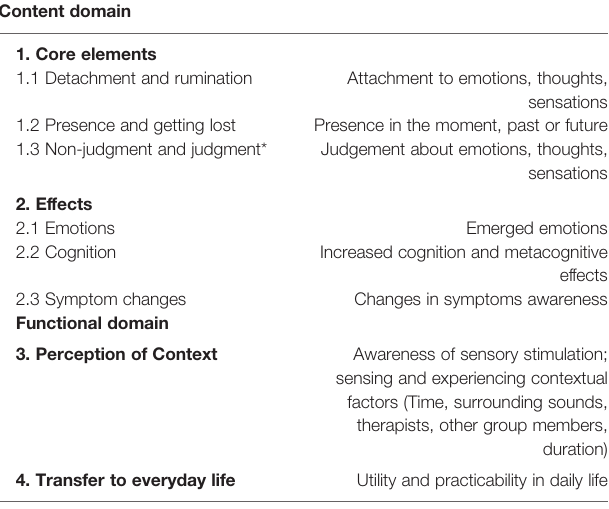
TABLE 4 | Description of